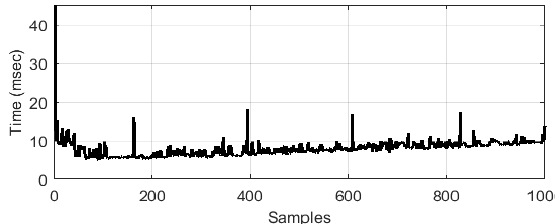
Figure 11. Computation times for the dynamic NMPC-PSO